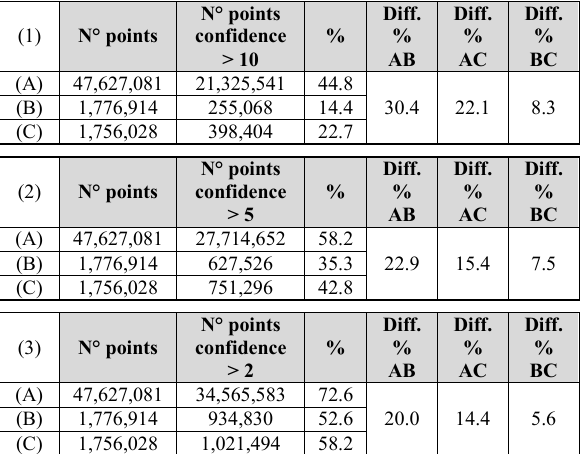
Table 8 . C. Alvaro-P.Gobetti school point cloud analysis. N° of points with confidence greater than 10 (1), 5 (2) and 2 (3) for: (A) visible dataset; (B) thermal dataset, Workflow 1; (C) thermal dataset, Workflow 2.